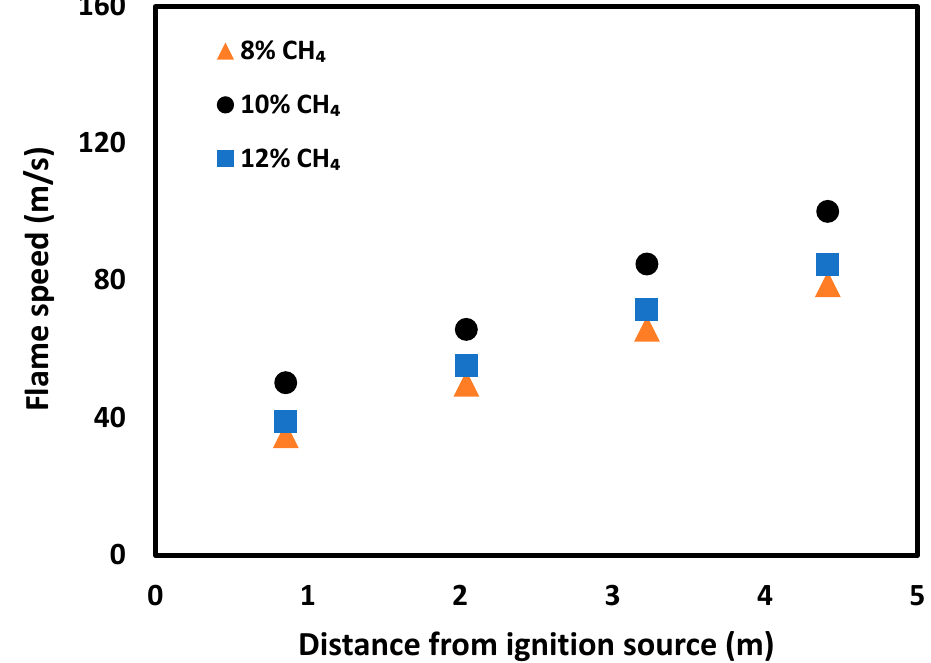
Figure 8. Developed flame propagation speeds of 8%, 10% and 12% methane concentrations along the length of the straight tube.